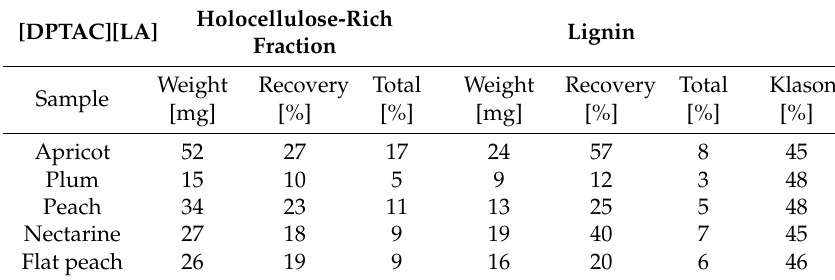
Table 4. Results from lignin extraction and holocellulose recovery using [DPTAC][LA] in pruning waste of five di ff erent fruit